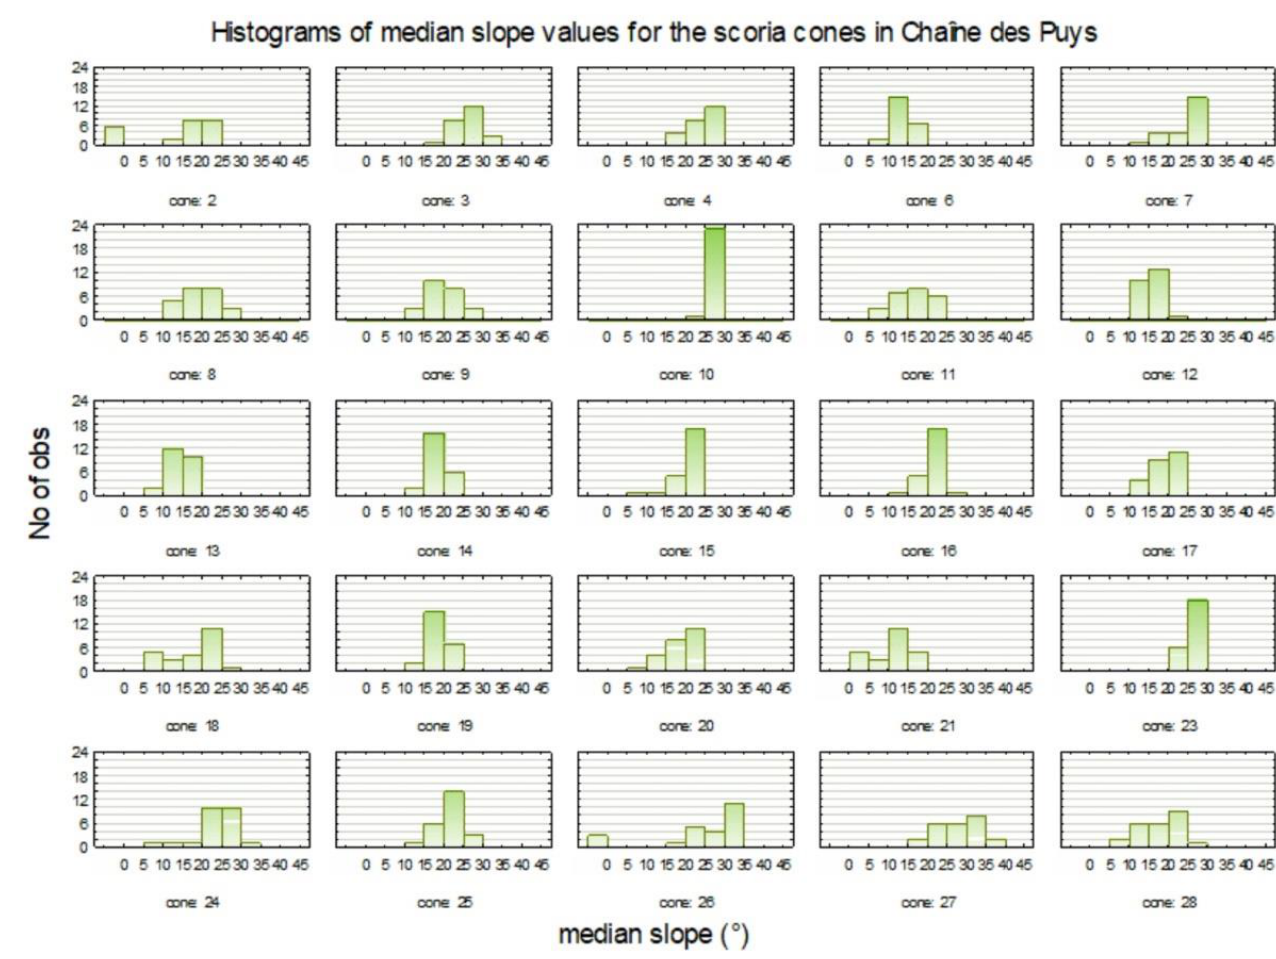
Figure 8. The histograms of the median slope angles of the sectors for the 25 cones studied of the Chaîne des Puys.